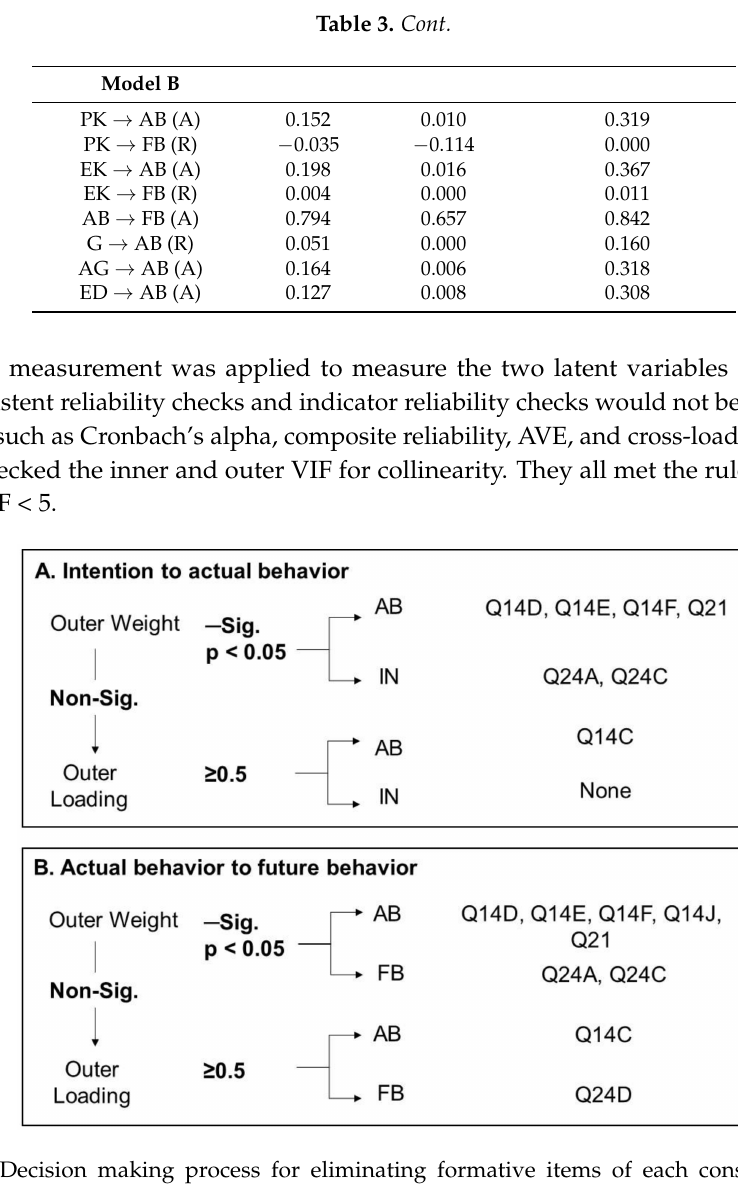
Figure 2. Decision making process for eliminating formative items of each construct and the results of the two SEM models: (Model A) planned behavioral model and (Model B) the habitual behavioral